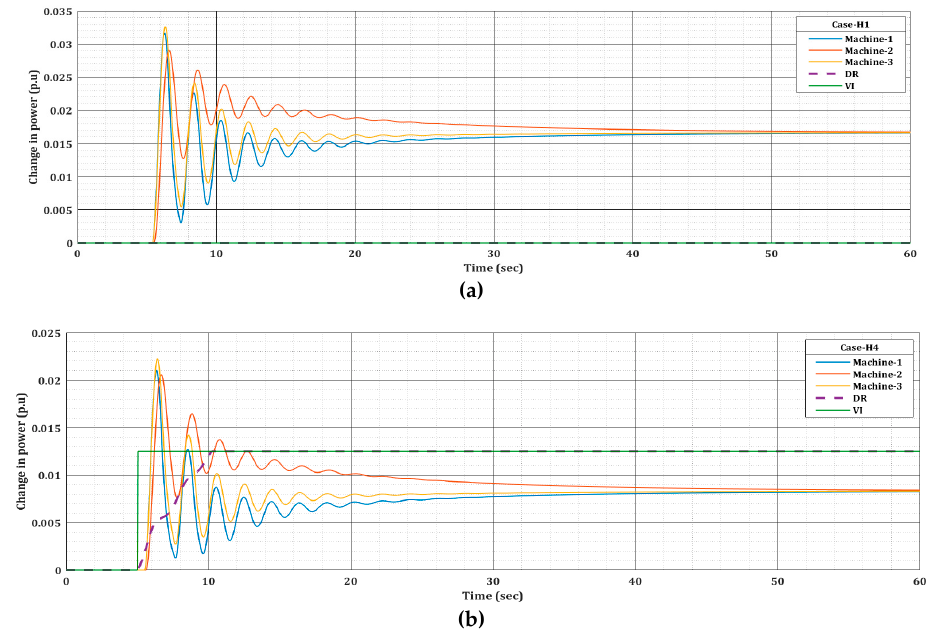
Figure 9. Change in power (p.u) for machines, demand response (DR) and virtual inertia (VI) resources ( a ) Case-H1 with 3 machines only; ( b ) Case-H4 with DR and VI resources in addition to 3 machines.